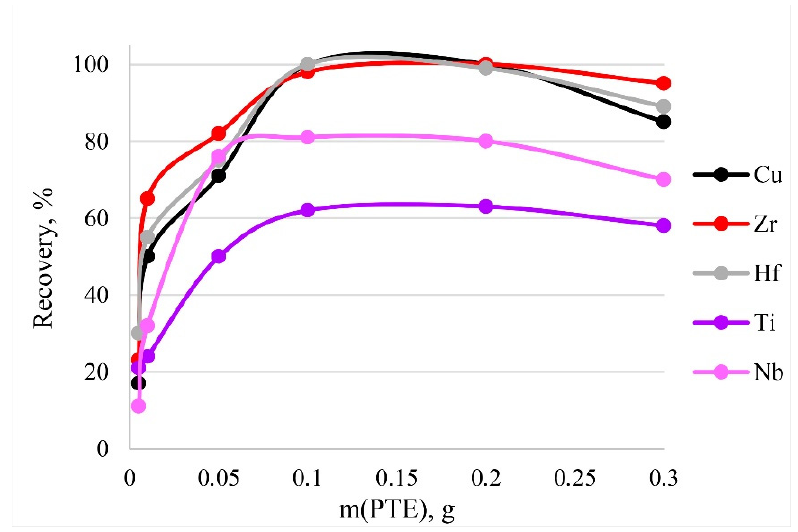
Figure 11. The dependence of recovery on mass of PTE. Sorption conditions: 0.1 mol/L HCl, C EDTA/NH3 = 50/2500 mg/L, V liquid phase = 10 mL, t = 30 min, T = 60 °C, c analytes = 1 mg/L.